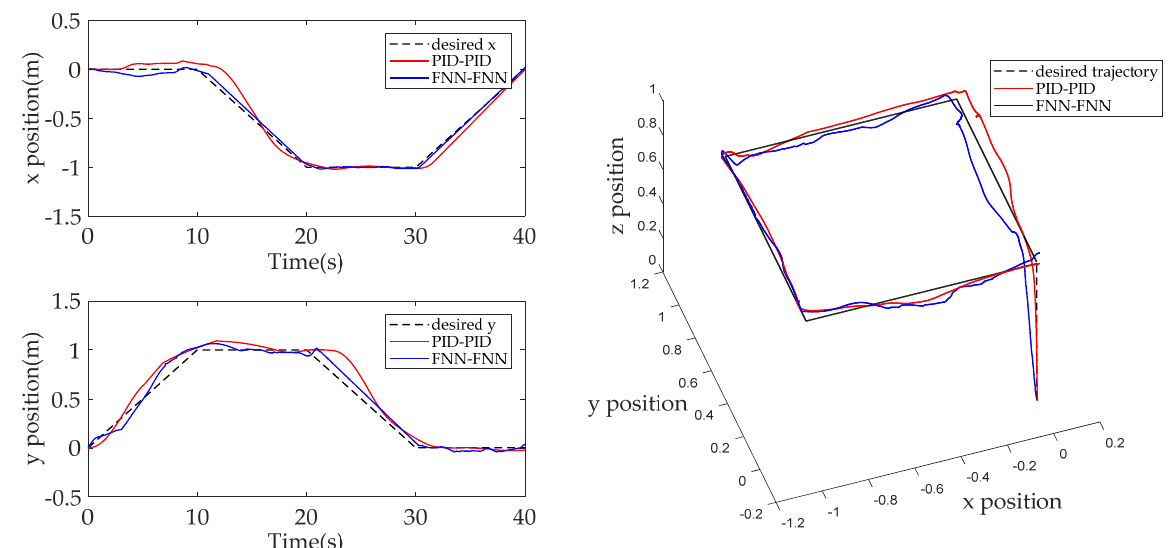
Figure 13. Experiment results of square trajectory tracking. The position root mean square error (RMSE) values for each flight are listed in Table 4.